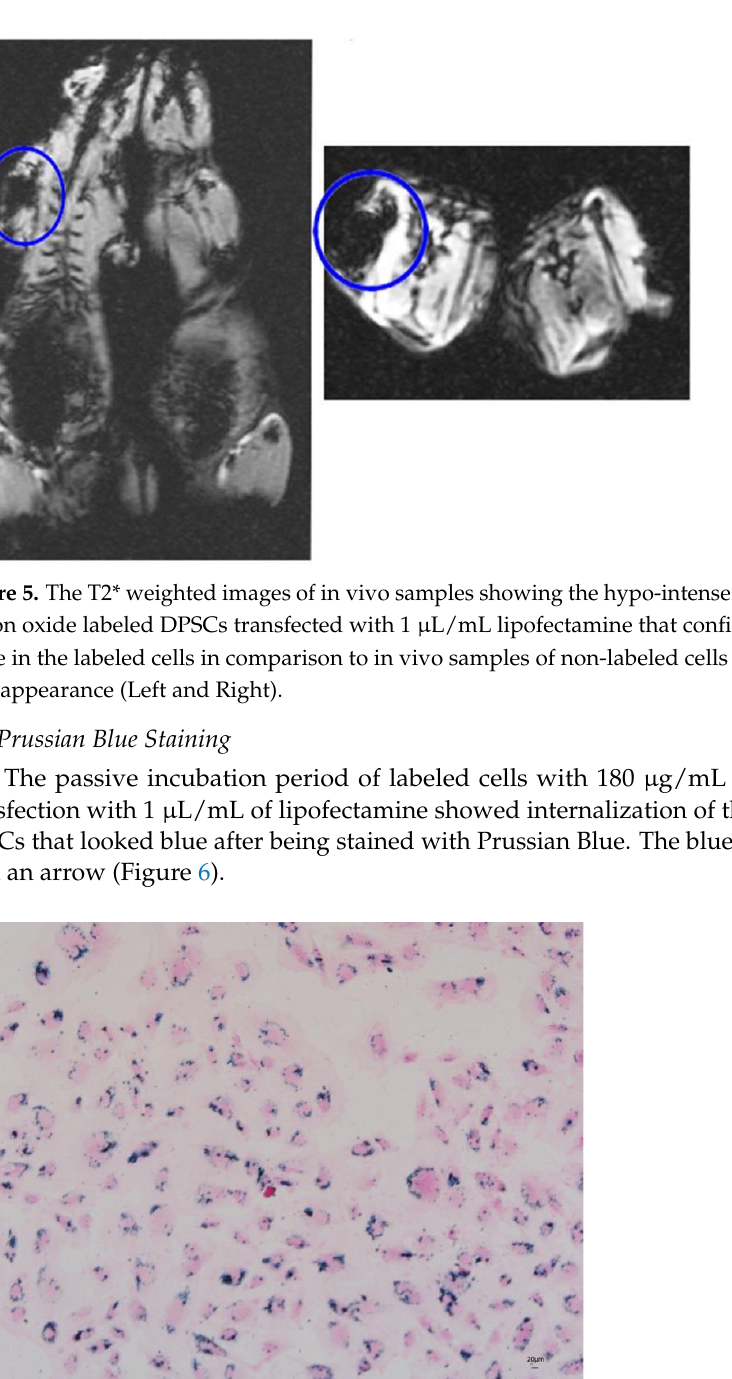
Figure 6. Prussian Blue staining of DPSCs labeled with 180 µg/mL of iron oxide and transfected with 1 µL/mL of lipofectamine to facilitate internalization of iron oxide nanoparticles that appear in blue color (4×).